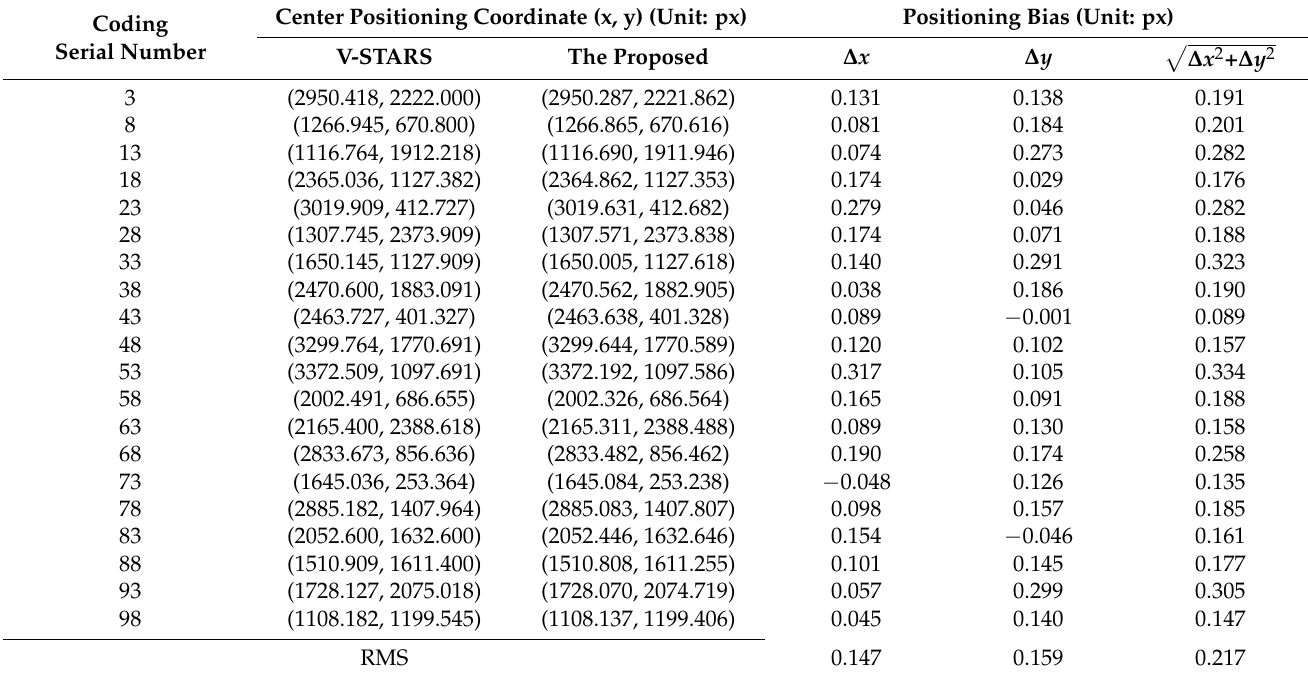
Table 8. The center positioning coordinates and positioning bias compared with V-STARS under the viewing angle at 0 ◦